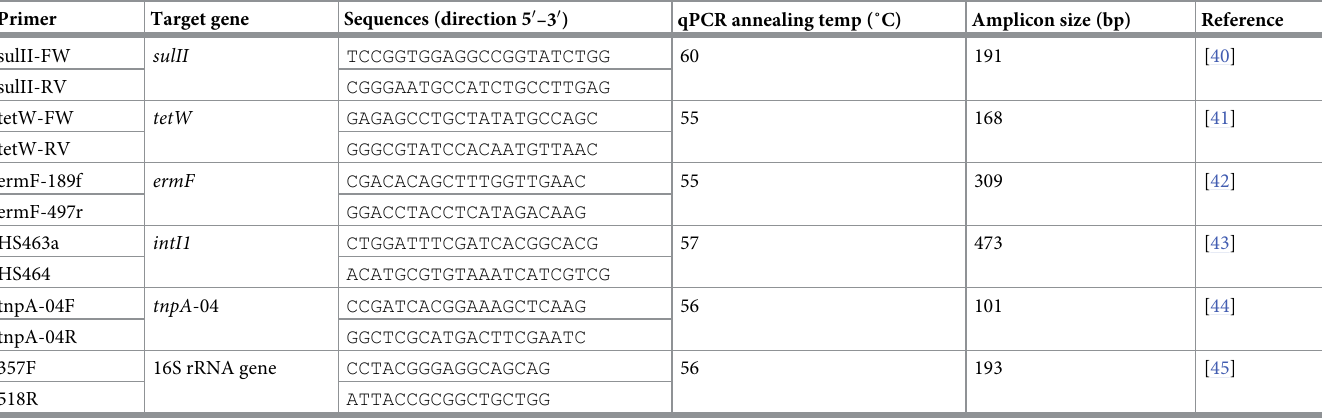
Table 1. Synthetic oligonucleotides and temperature regimes used for qPCR reactions. Primer Target